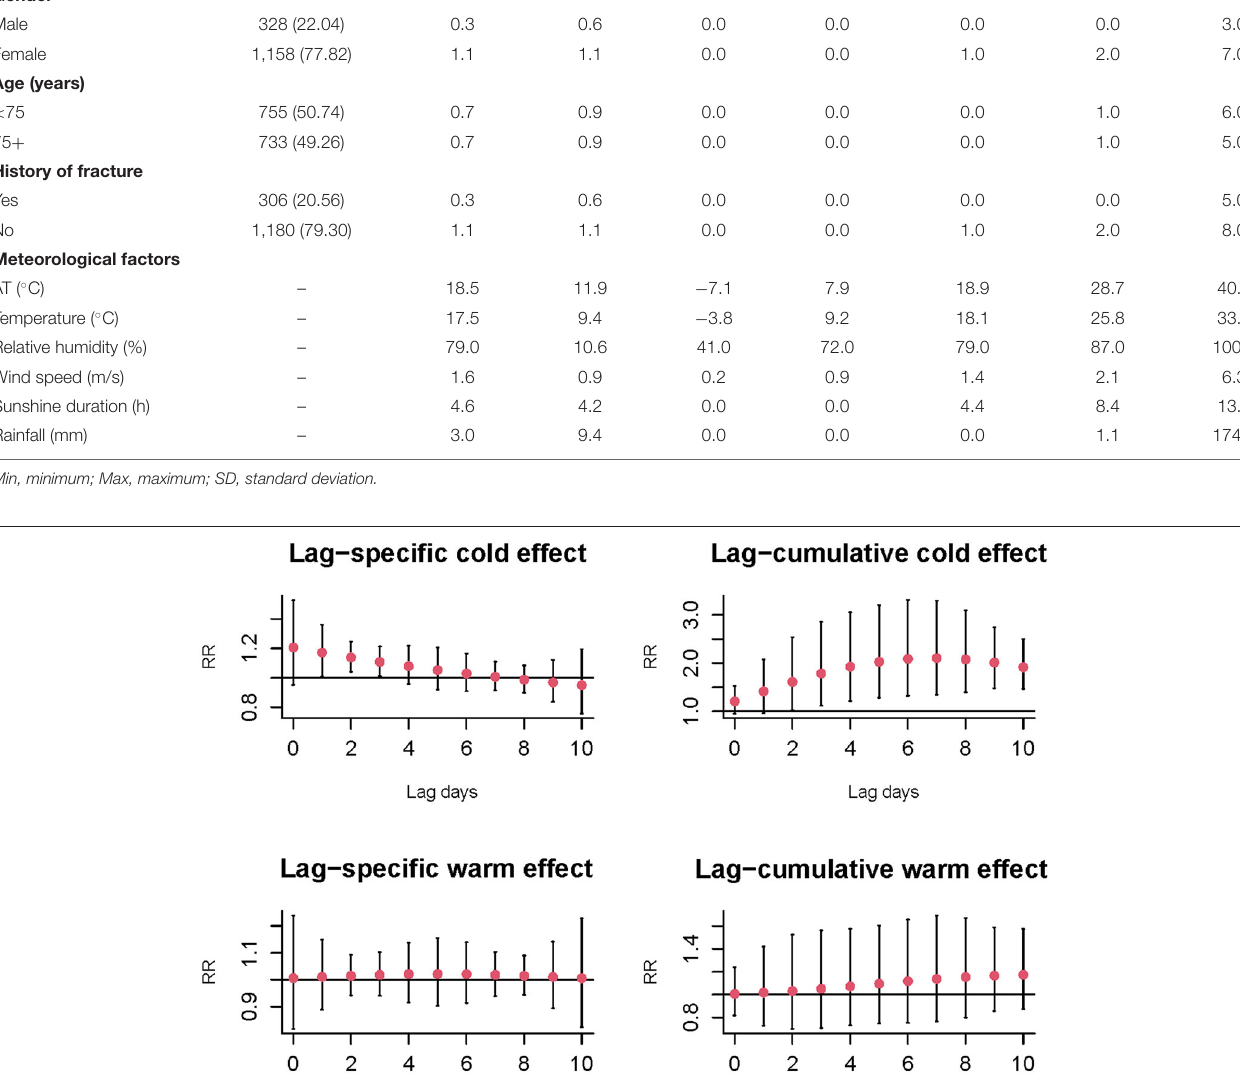
No significant associations of warm effects and osteoporotic fractures were observed in subgroup analyses, as seen in Supplementary Figure S10 and Supplementary Table S4 . The results of Z -test for the differences within each subgroup for the risks of cold effects at lag 2 day were shown in Figure 3 . No statistically significant differences were found in gender, age,